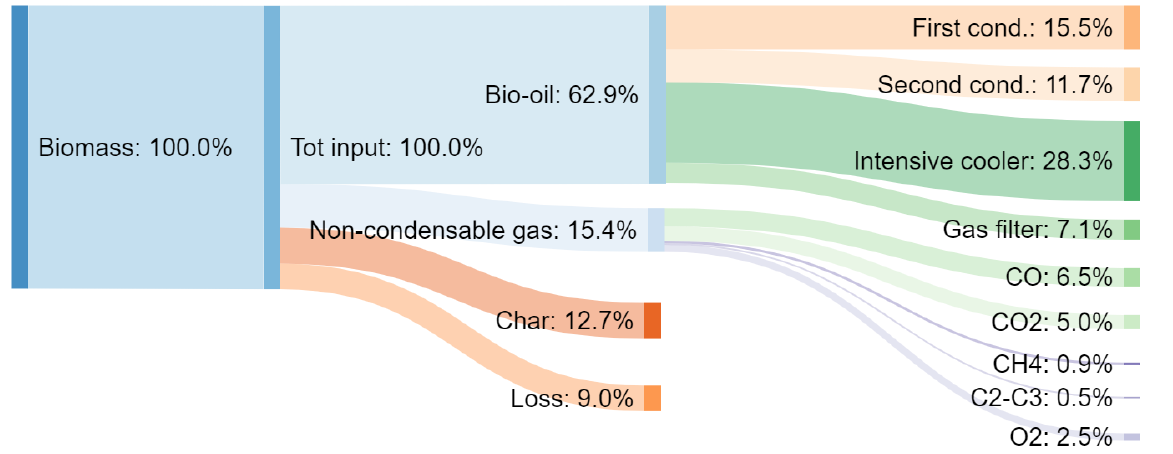
Figure 7. Average mass balance (Nitrogen-free).